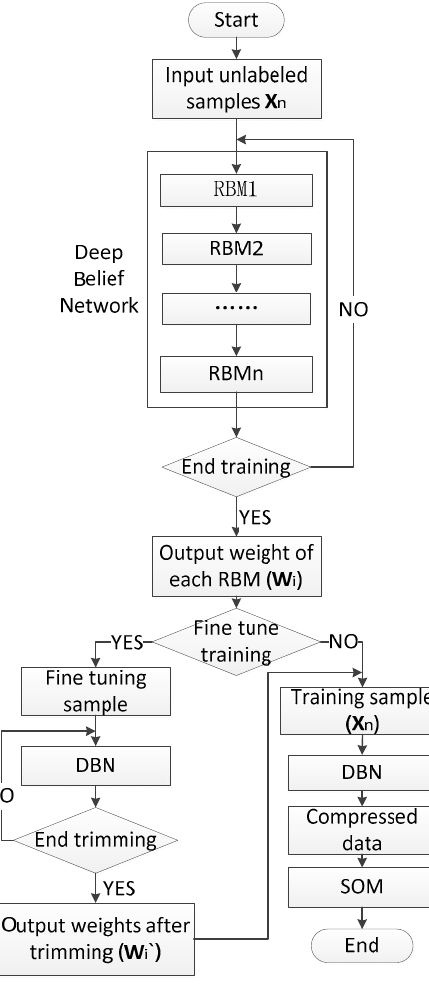
Figure 2. Flowchart of the training.